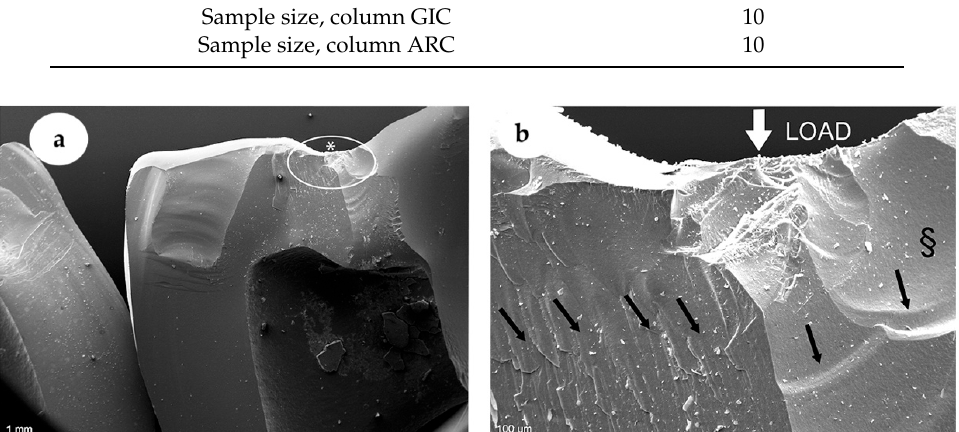
Figure 3. SEM images showing representative ZLS crown of GIC Group. In ( a ), (32 × magnification) the tracture of a ZLS crown is shown. The * indicates the area showed at a higher magnification in ( b ) (200 × magnification). Meanwhile, the white arrow shows the load application point. No residual portions of the abutments were attached to the crown. The § shows the fracture pattern and the presence of “mirror” areas near the point of force application. Black arrows indicate a fracture surface with several “hackle” areas and the direction of fracture propagation.